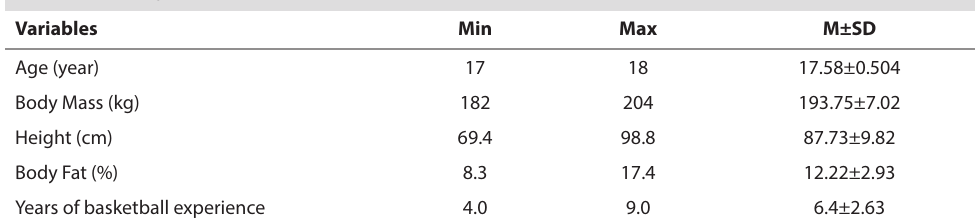
TABLE 1. Demographic Characteristics of